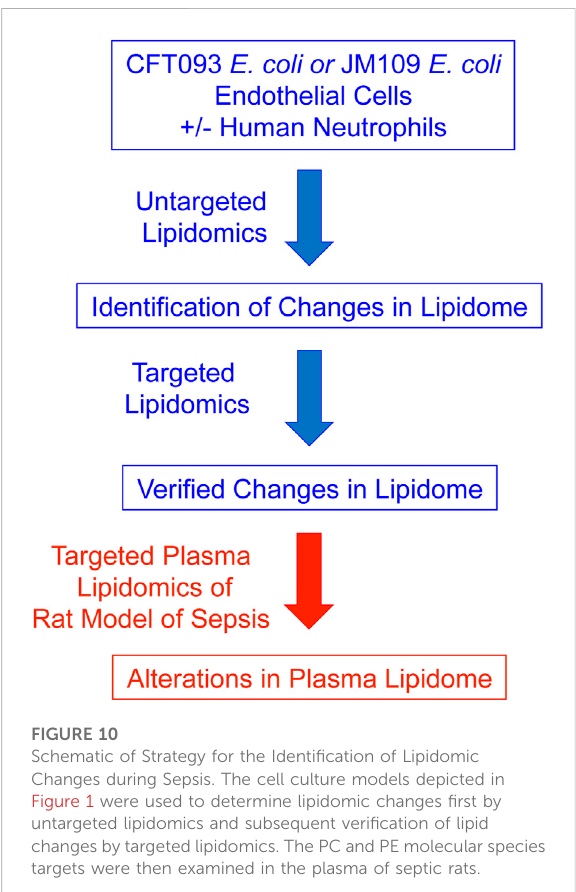
FIGURE 10 Schematic of Strategy for the Identi fi cation of Lipidomic Changes during Sepsis. The cell culture models depicted in Figure 1 were used to determine lipidomic changes fi rst by untargeted lipidomics and subsequent veri fi cation of lipid changes by targeted lipidomics. The PC and PE molecular species targets were then examined in the plasma of septic